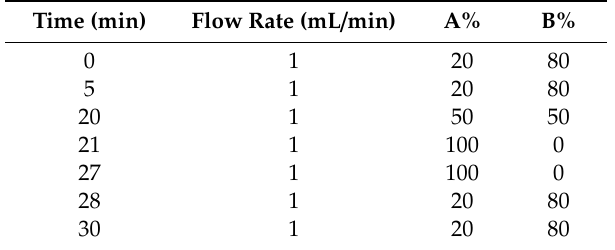
Table 1. GABA separation method used for liquid chromatography. Time